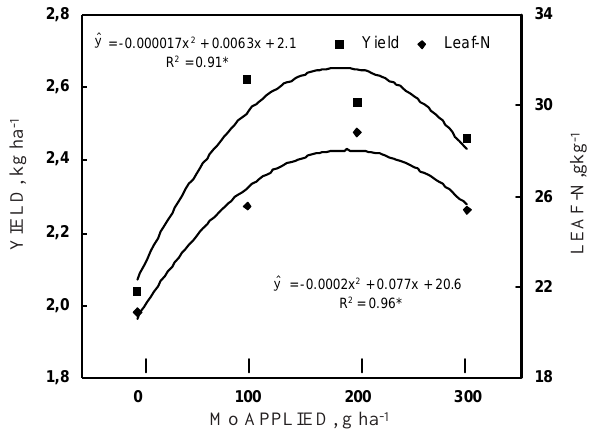
Figure 2. Effects of molybdenum rates on yield and nitrogen concentration in peanut leaves. Data of treatment without lime application. (Averaged results of three successive harvests) * significant at 0.05 probability.